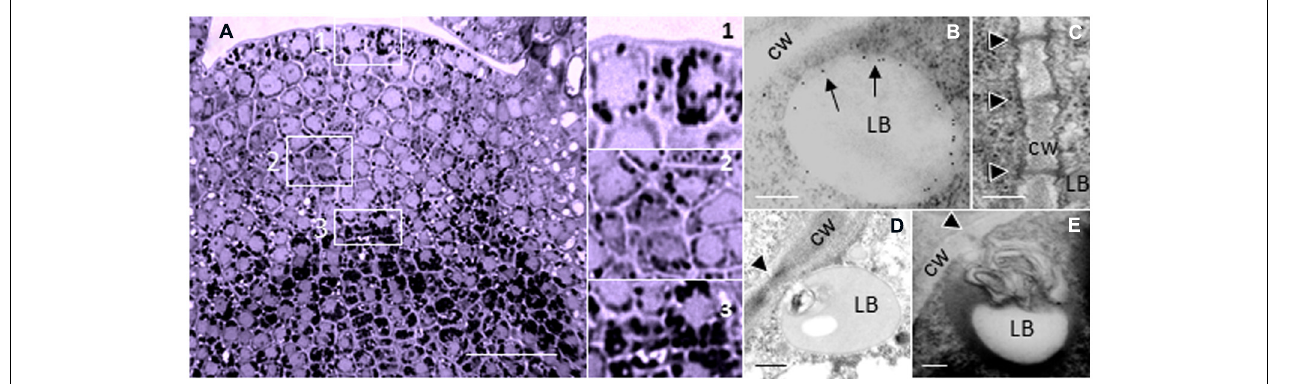
FIGURE 1 | Lipid bodies in the perennial shoot apex. (A) Shoot apex of hybrid aspen ( Populus tremula × P. tremuloides ) after exposure to short photoperiod results in the accumulation of LBs during initiation of dormancy. LBs are visualized by Sudan Black B. Boxed areas (1–3) are detailed on the right; 1 = Tunica, 2 = Corpus, 3 = Rib meristem/Rib zone. (B–E) Electron microscopic images of LBs in shoot meristem of birch ( Betula pubescens ) during chilling-induced release from dormancy. (B) Immuno-gold-labeling of 1,3- β -glucanase, peripherally associated with